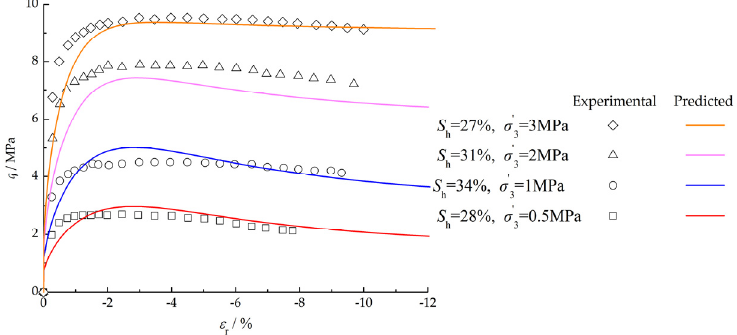
Figure 5. Comparison of the predicted stress–strain curves with the experimental results [24].